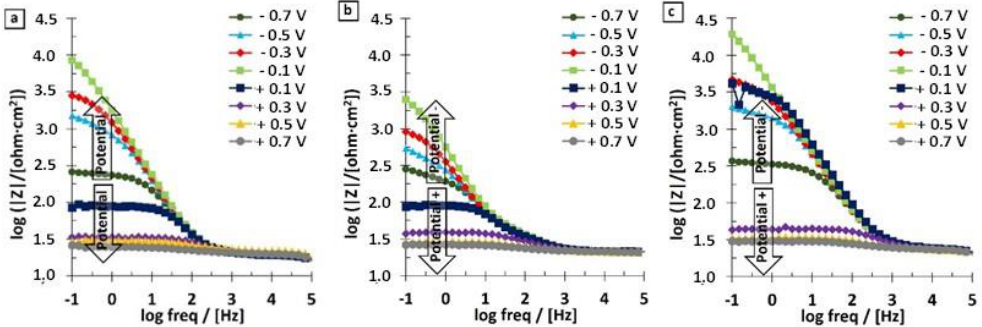
Figure 5. Bode-IZI spectra for ( a ) Al 1.0 , ( b ) Al 0.8 , and ( c ) Al 0.6.